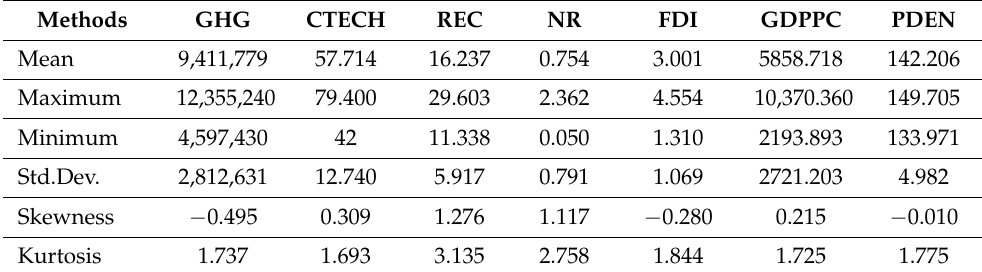
Table 2. Descriptive Statistics.